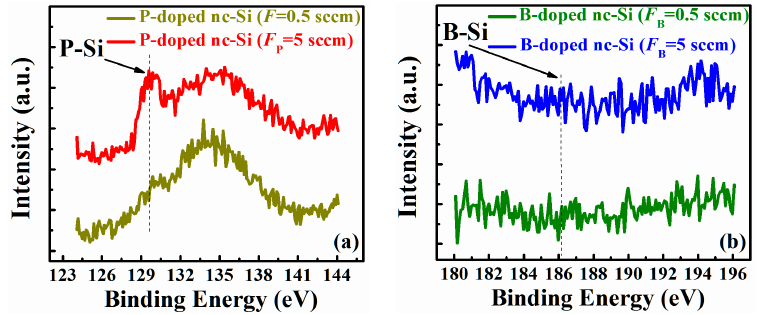
Figure 3. X-ray photoelectron spectroscopy (XPS) spectra of doped nc-Si films: ( a ) P-doped samples with different F P ; and ( b ) B-doped samples with different F B .